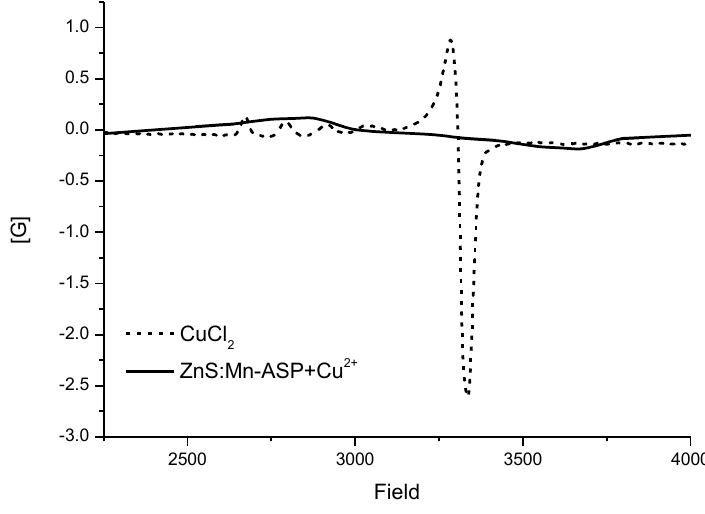
Figure 9. X-band electron paramagnetic resonance (EPR) spectrum of the ZnS:Mn-Asp-Cu adduct (solid) taken at 200 K. The spectrum of a paramagnetic CuCl 2 (d 9 ) solid (dashes) is also presented for comparison.